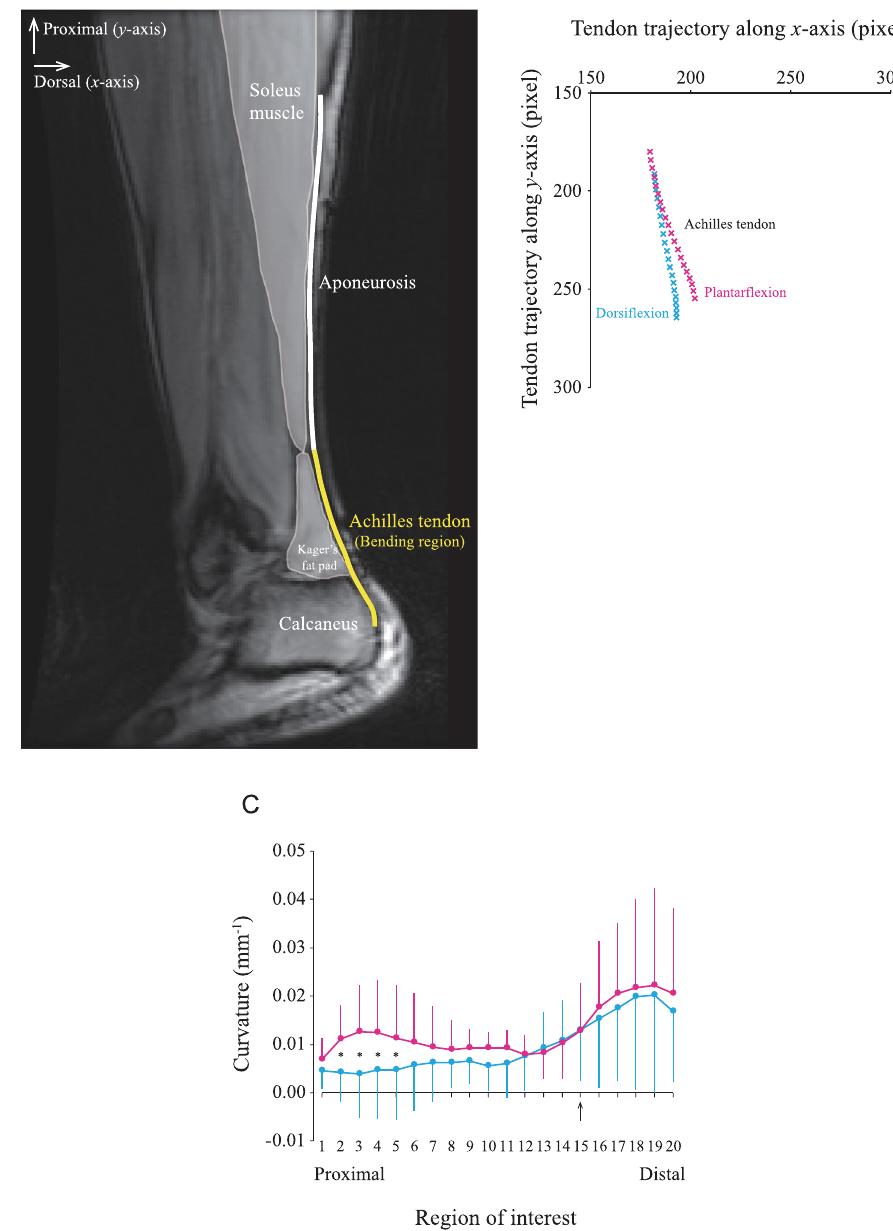
Figure 1. The trajectory and curvature along the entire length of the Achilles tendon during passive movement of the ankle. ( A ) Oblique sagittal magnitude MR image of the lower leg muscles. The thick white line is the aponeurosis proximally, and the thick yellow line is the Achilles tendon distally. The Achilles tendon is the line from the distal edge of the soleus muscle (start point) to the point of tendon insertion on the calcaneus, i.e., the inferior calcaneal tuberosity (end point). The line is almost straight in the aponeurosis region, but it is bent ventrally in the Achilles tendon region. The regions of interest were manually positioned at 20 points from the start to the end points of the Achilles tendon. ( B ) Scatter diagram of the x and y coordinates of the Achilles tendon with the ankle fully dorsiflexed (blue, cross symbol) and fully plantarflexed (pink, cross symbol). A one-way ANOVA was used to examine the difference in the entire length of the Achilles tendon between plantarflexion and dorsiflexion and to examine the differences in the vertical displacement and resultant vector between the start and end points of the Achilles tendon. Each data point represents the averaged values of 10 subjects. ( C ) The curvature of the entire Achilles tendon is compared between full ankle dorsiflexion and plantarflexion. The black arrow on the X -axis is an anatomic landmark corresponding to the same level as the boundary line between the most distal edge of the Kager’s fat pad and the superior calcaneal tuberosity. The difference in the curvature of the Achilles tendon was tested with a two-way ANOVA (2 ankle positions × 20 regions of interest). Each data point is represented by the mean and SD of n = 10. * indicates a significant difference ( P < 0.05) between plantarflexion and